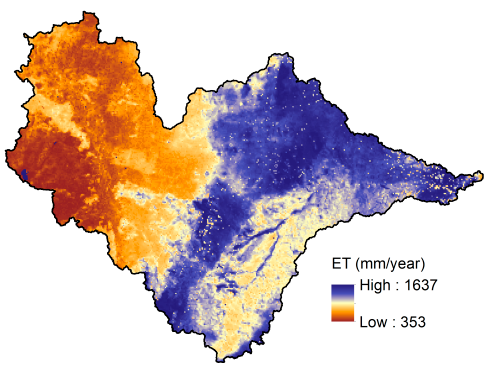
Figure 3. Average annual MODerate resolution Imaging Spectroradiometer evapotranspiration (MODIS ET) (2000–2013).